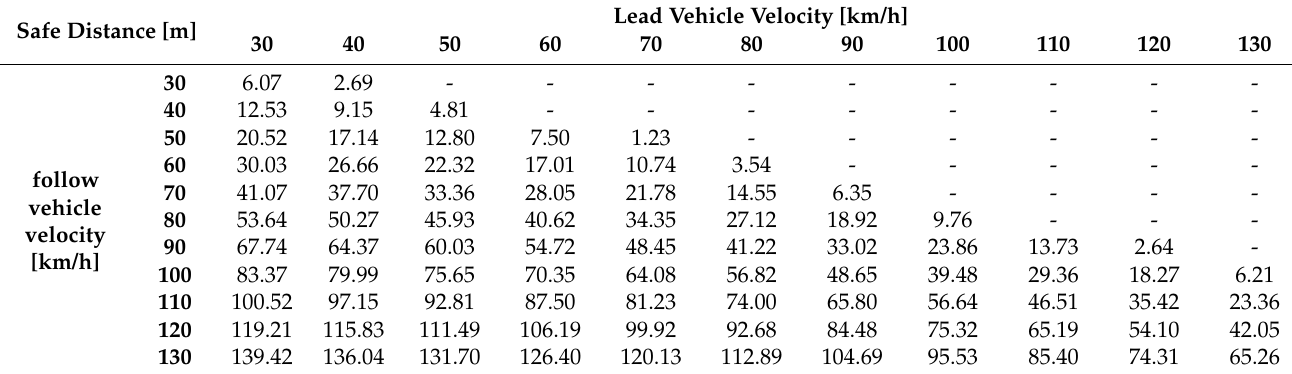
Table 3. Safe distance for speed of GENESIS GV80 3.5 T